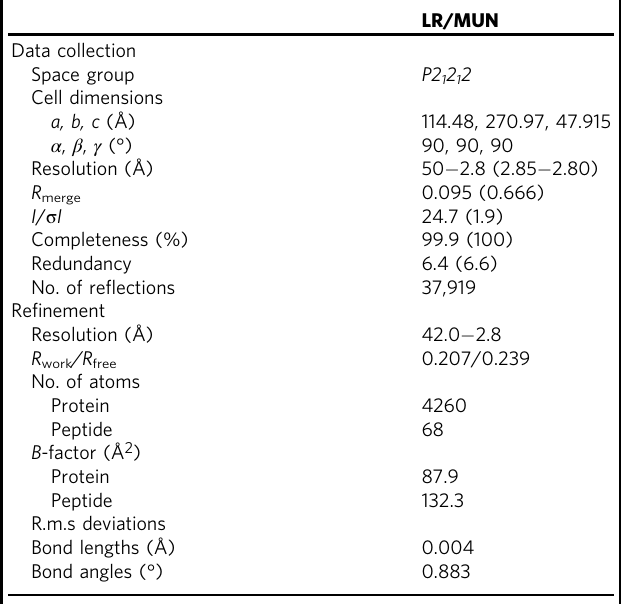
Table 1 Data collection and re fi nement